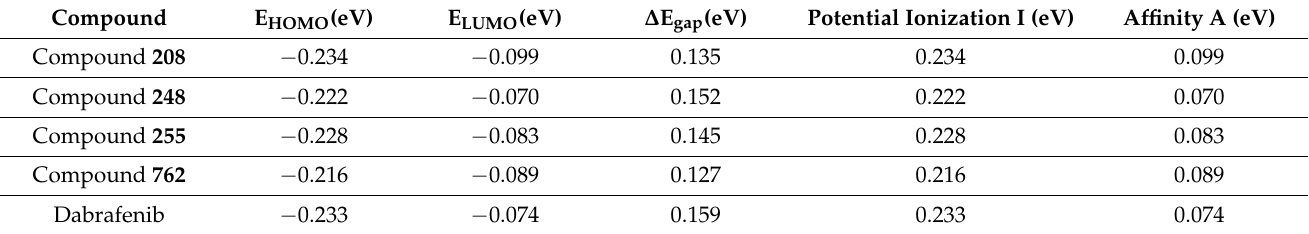
Table 2. ∆ E gap of HOMO/LUMO orbitals of selected compounds.